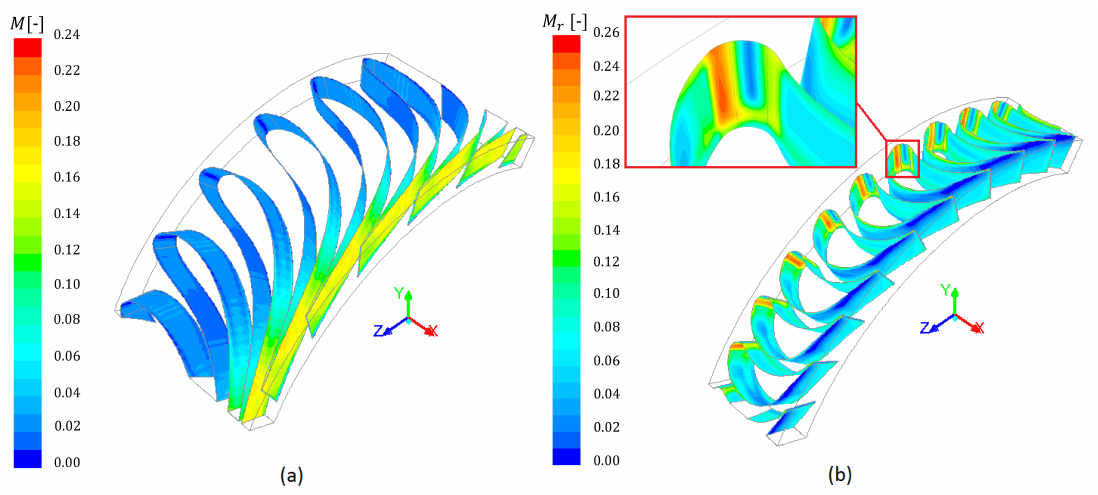
Figure 14. ( a ) Mach number distribution around stator blades ( b ) Relative Mach distribution around rotor